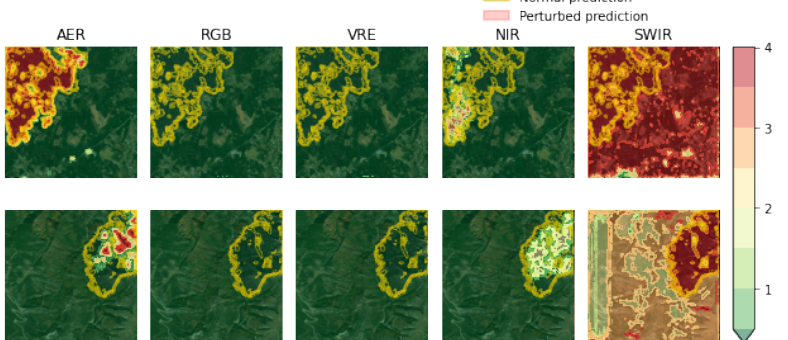
Figure 9. Visualization of the all_occlusion results for the different Multi-bands. Yellow contours indicate the severity scale region of the normal prediction. The perturbed prediction is indicated via the colored regions as in the